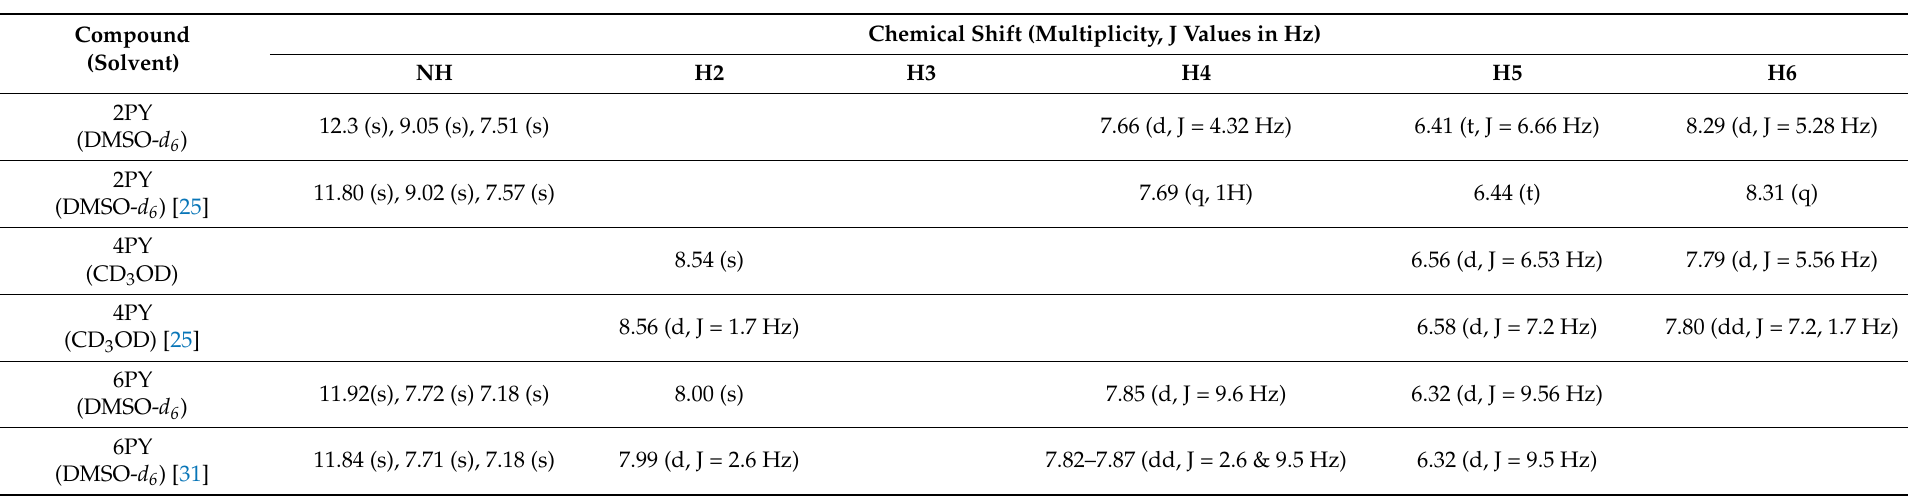
Table 1. Tables of 1 H NMR chemical shift for the non-substituted